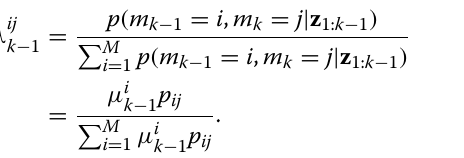
computed by Bayes rule using the mode transition proba- bility and the mode distribution in the previous stage μ k − 1